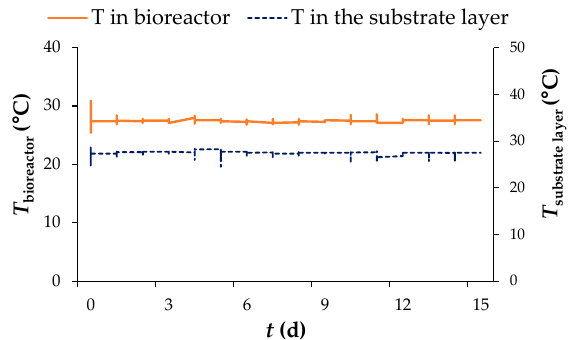
Figure 1. Temperatures in a tray bioreactor and in the substrate layer during SSF.